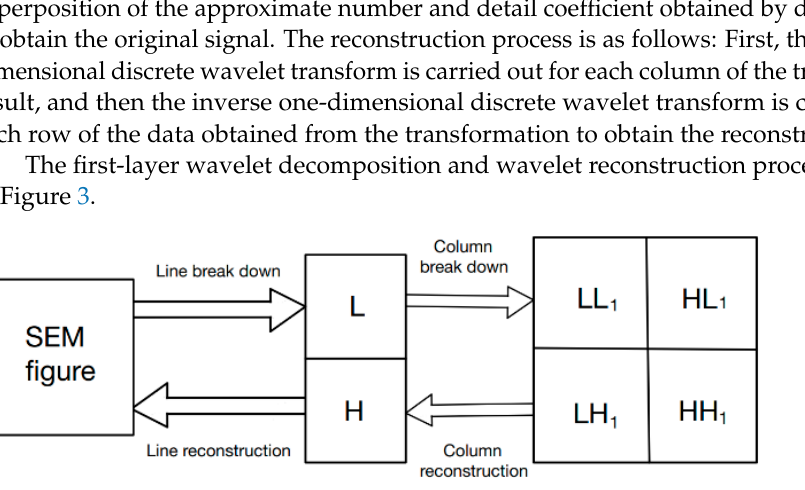
Figure 3. Flow diagram of wavelet decomposition and reconstruction.